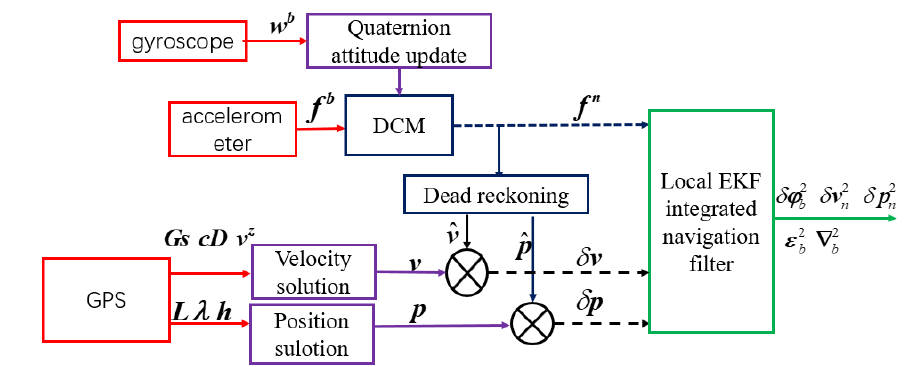
Figure 6. The nonlinear strapdown inertial navigation system (SINS)/GPS local EKF